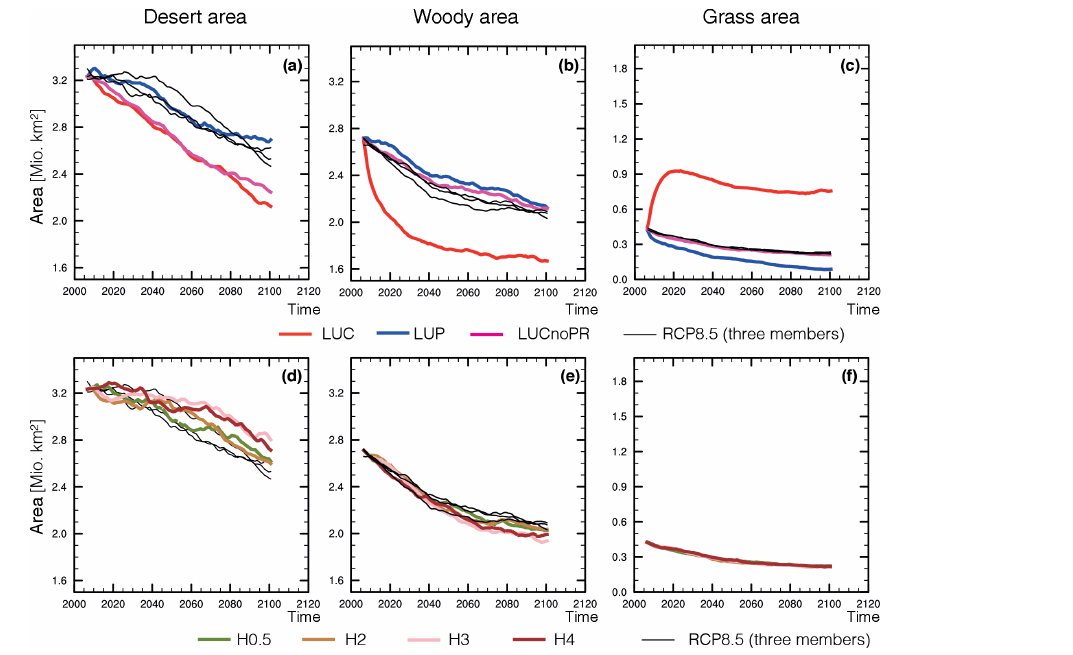
Figure 6. Temporal evolution in the desert area (a, d) and the natural vegetation grouped for woody type (b, c) and grass type (d, e) , separately. In comparison to the results of the three ensemble members of the CMIP5 RCP8.5 scenario (black solid lines), the figures in the top row show the extreme land use scenarios in coloured dashed lines, while the bottom row displays the results for different harvest rates (H0.5 to H5).